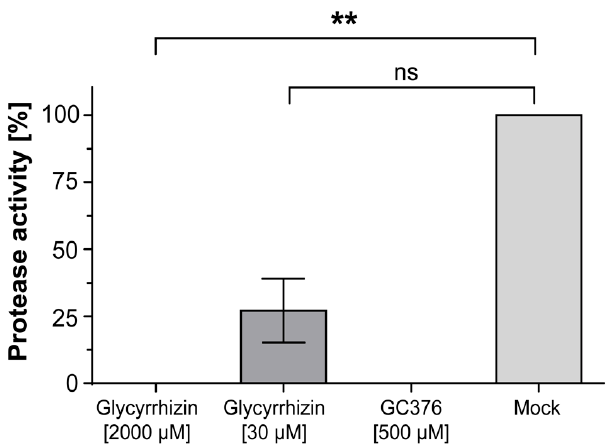
Figure 1. Glycyrrhizin potently inhibits the viral main protease (M pro ). The inhibition of SARS-CoV-2 M pro by glycyrrhizin was measured using the “Fluorogenic 3CL Protease, MBP-tagged (SARS-CoV-2) Assay Kit”. Different glycyrrhizin concentrations (30 μ M and 2000 μ M) and the complete protease inhibitor GC376 (100 μ M) were dissolved with 90 ng M pro in 30 μ L 0.5 M DTT Buffer and incubated for 30 min at room temperature. Subsequently, the 3CL Protease (SARS-CoV-1/SARS-CoV-2) substrate was added and the protease activity was measured after overnight incubation at a wavelength of 360 nm/460nm ( exc/em ). The experiment was performed in triplicates. Measurement was performed using Mithras LB 943 after 12 h incubation. Statistical analysis was undertaken with a non-parametric ANOVA test. Comparisons were considered significant at ** p < 0.01 and n.s. = no significance. All experiments were performed in biological replicates. Error bars represent the standard derivation of the mean